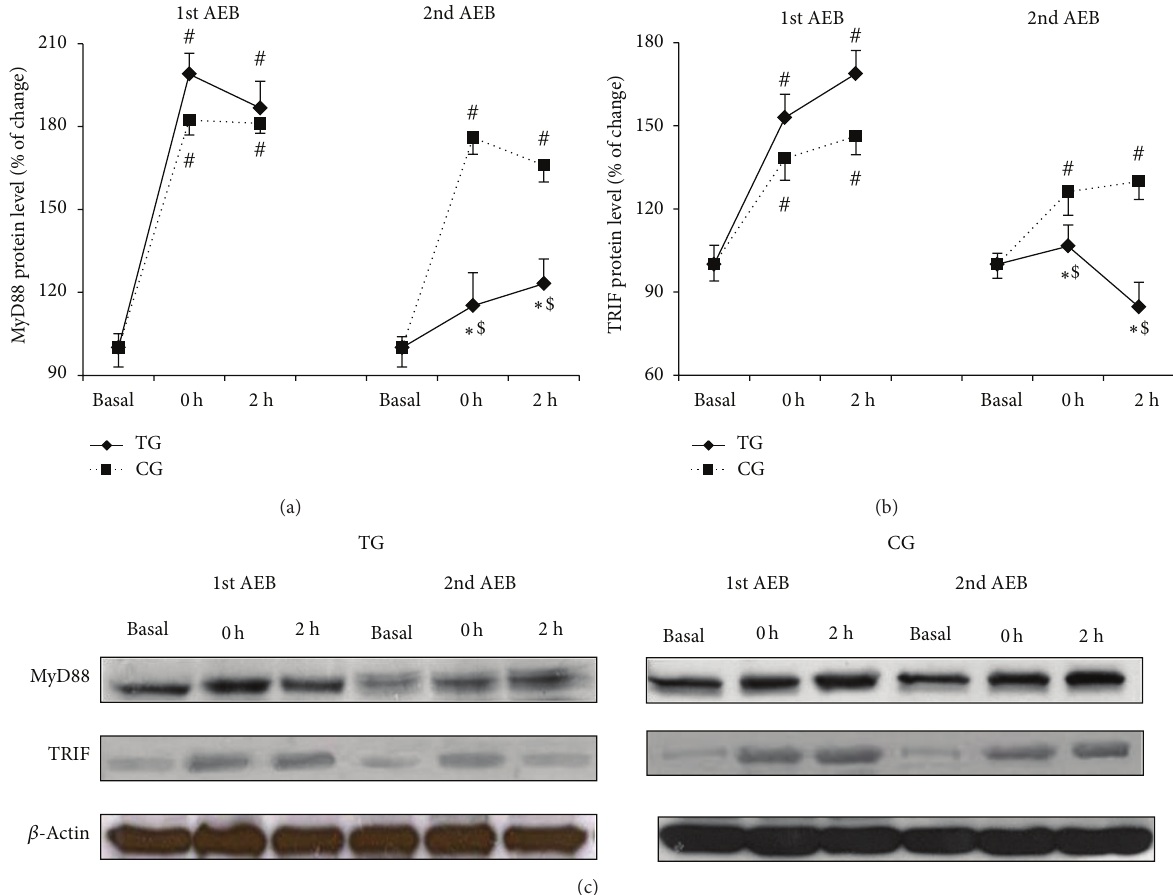
Figure 2: Training reduces MyD88 and TRIF protein overexpression induced by acute eccentric exercise. MyD88 (a) and TRIF (b) protein levels after the first and the second acute eccentric bout (AEB) for training group (TG, solid line) and control group (CG, dotted line) and representative Western blots (c). Mean ± SEM. ∗ 𝑃 < 0.05 versus CG; # 𝑃 < 0.05 versus basal value, same group; $ 𝑃 < 0.05 versus 1st acute eccentric bout, same